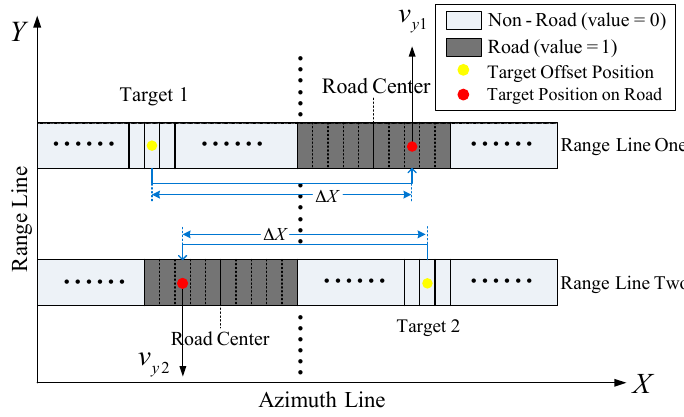
Figure 2. Principle of moving target location on the road.